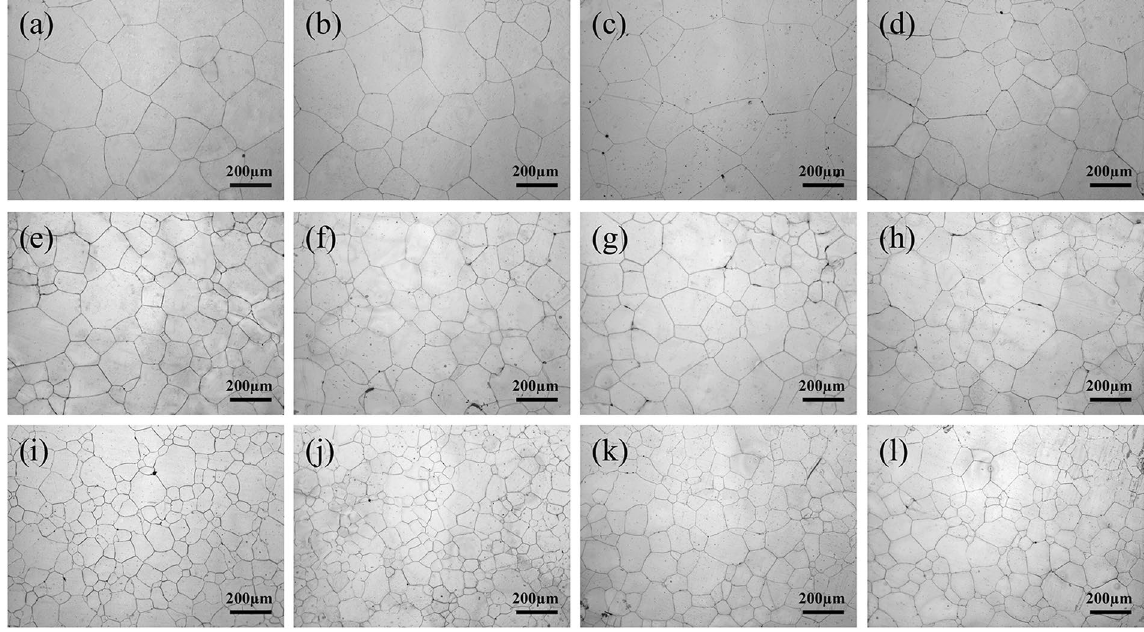
Figure 1. Optical microscopy images of Mg-3Zn alloy microstructures: ( a ) unrolled and subjected to solution treatment at 420 °C for 24 h; ( b ) further aged at 170 °C for 10 h, ( c ) 25 h, and ( d ) 60 h; ( e ) as-rolled (20%) and subjected to solution treatment at 420 °C for 24 h; ( f ) further aged at 170 °C for 10 h, ( g ) 25 h, and ( h ) 60 h; ( i ) as-rolled (50%) and subjected to solution treatment at 420 °C for 24 h; and ( j ) further aged at 170 °C for 10 h, ( k ) 25 h, and ( l ) 60 h.